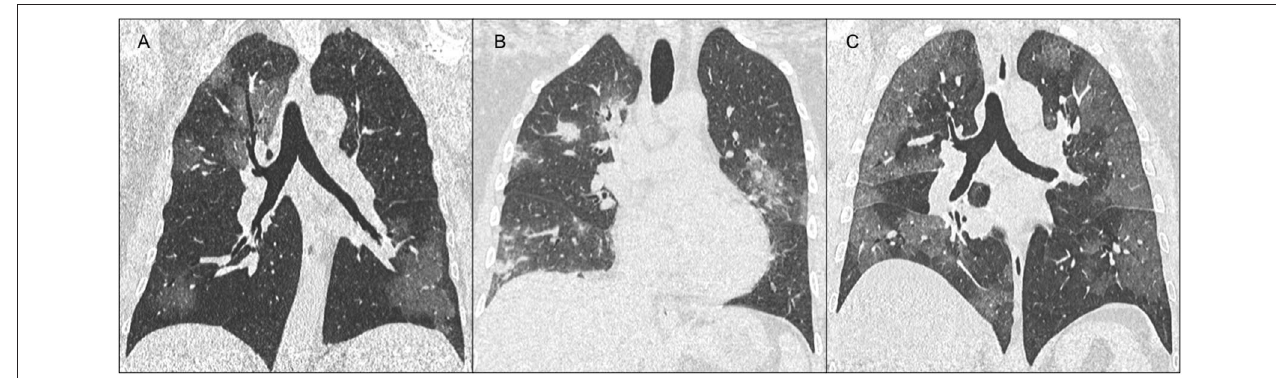
FIGURE 2 | Representative computed tomography (CT) images of various manifestations of the COVID-19. (A) Coronal chest CT images show patchy ground-glass opacities involving both lungs. (B) Ground glass may also appear widespread, confluent, and peripherally distributed. (C) Consolidation and rounded nodules may be also observed in association with ground glass